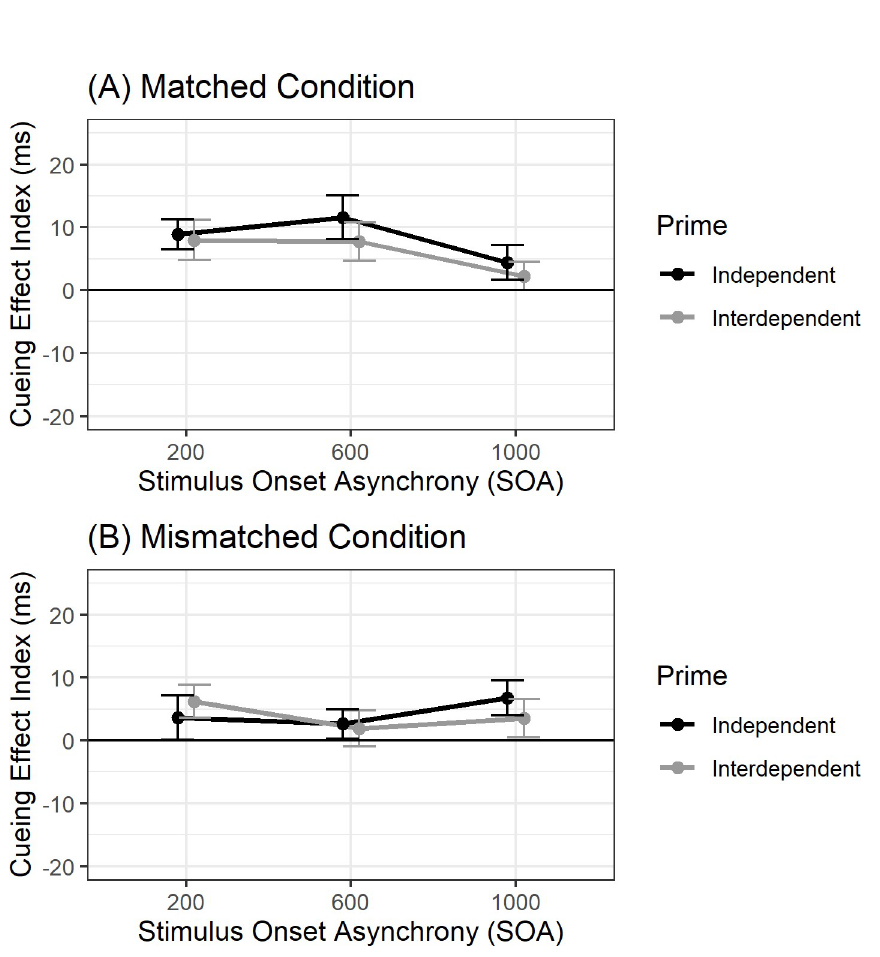
Fig 2. Cueing effects for European Canadians. Note : Cueing Effect Index as a function of SOA and Prime for (A) matched and (B) mismatched conditions. Error bars represent standard error of the mean. Participants are European Canadians.